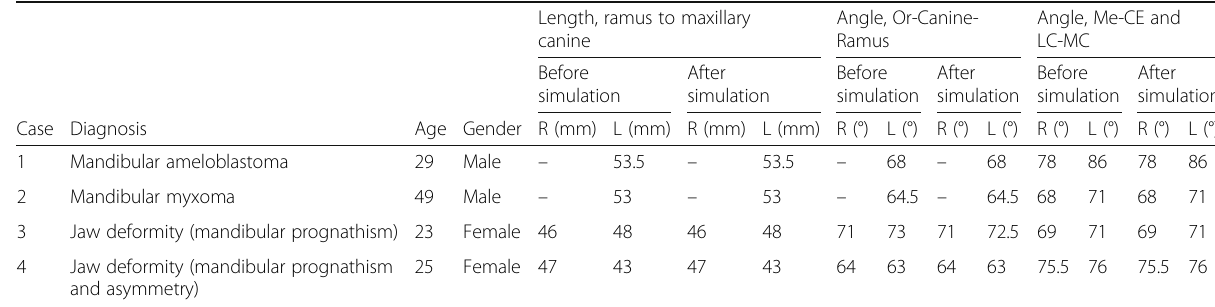
Table 1 Measurement results